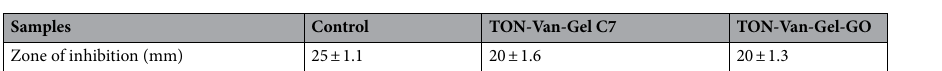
Table 7. The values ± SD for inhibition zone obtained from disc diffusion assay against S . aureus .